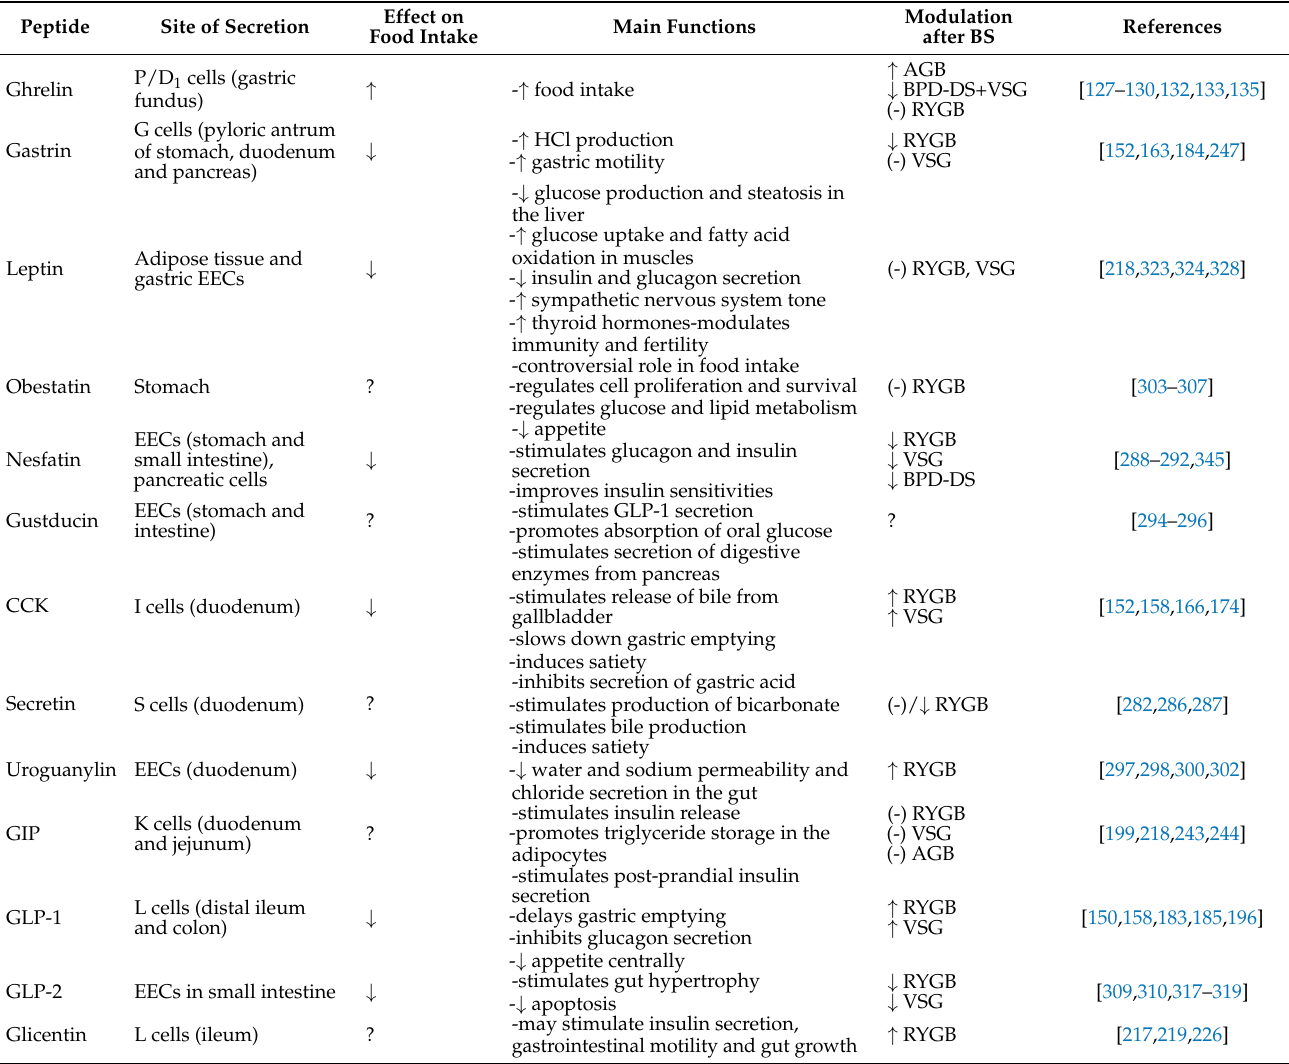
Table 1. Gut peptides and their alterations after